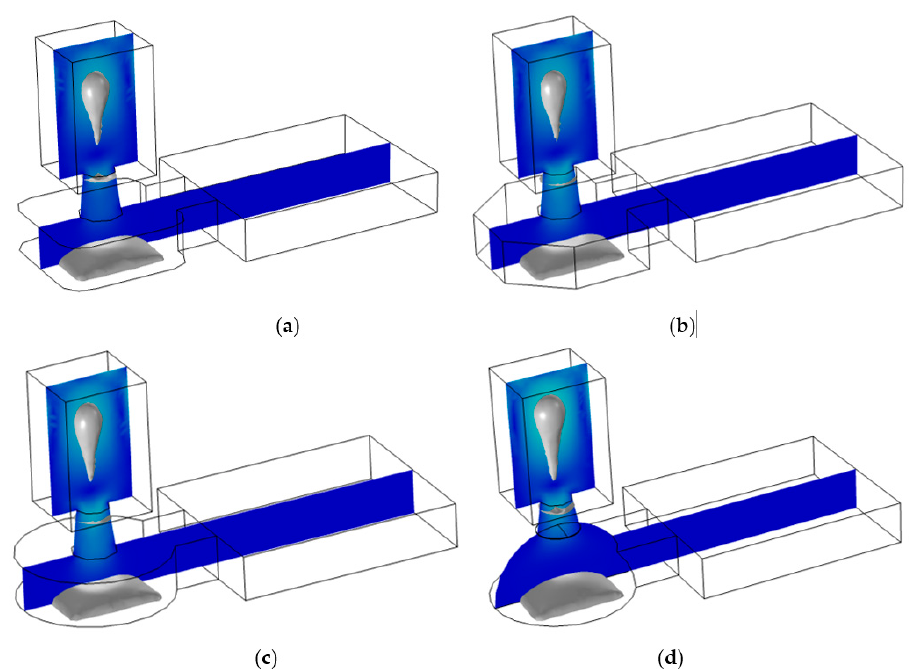
Figure 13. The volume of droplets under different inkjet heads. ( a ) For the square inkjet head, the droplet volume is 8.8 pL; ( b ) For the trapezoidal inkjet head, the droplet volume is 9.0 pL; ( c ) For the round inkjet head, the droplet volume is 9.2 pL; ( d ) For the hemispherical inkjet head, the droplet volume is 10.7 pL. Table 3. Comparison of different shapes of inkjet